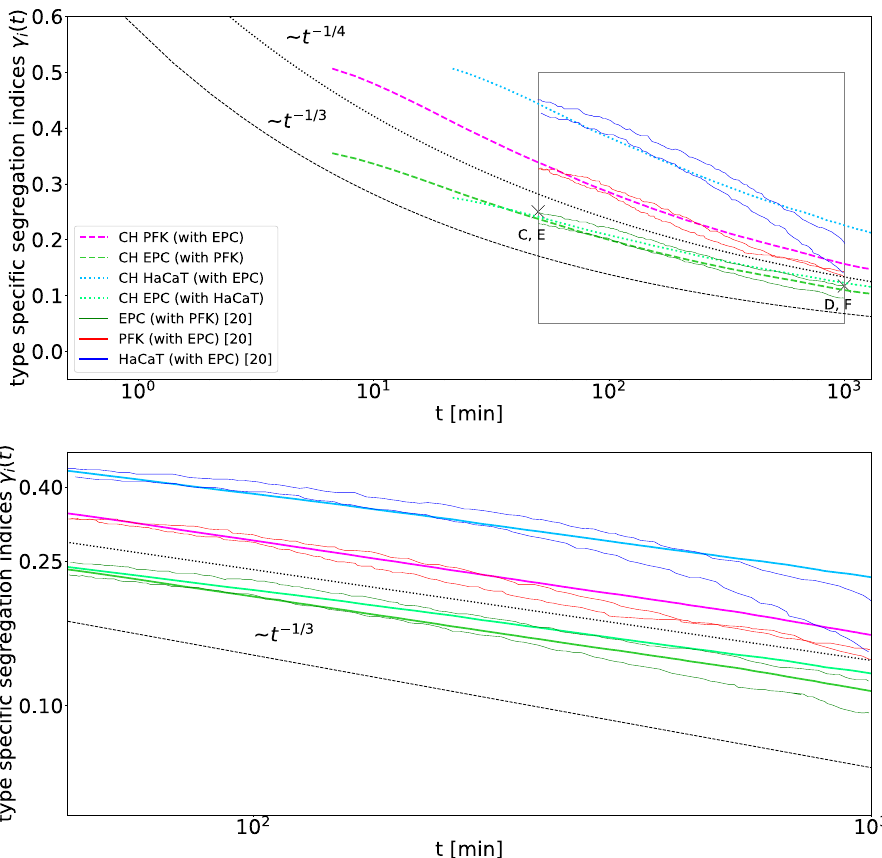
( t ) for the two experiments PFK (dark red) with EPC (dark green) and HaCaT (dark blue) i with EPC within the observed time interval 50–1000 min match the segregation indices predicted by the Cahn-Hilliard simulation (lines with corresponding brighter colors, dashed lines for PFK with EPC and dotted lines for HaCaT with EPC). Within the given time interval (grey box in top panel displayed again in bottom panel), the segregation indices of the Cahn-Hilliard simulation decay algebraically with exponent 1/4 (black dotted line) rather than 1/3 (black dashed line), which implies that the segregation process is in an intermittent regime of fluid segregation, see text for details. By using a mapping from the cellular automaton model to the Cahn-Hilliard model, see Materials and methods, parameters are set analogous to the parameters used in Fig 1 except for the mobility constant D , which is fitted to D ¼ 36 m m 2 = min for the mixture of PFK with EPC and D ¼ 18 m m 2 = min for the mixture of HaCaT with EPC. Snapshots of the cell mixtures at the points marked with crosses labeled C, E and D, F are displayed in Fig 3. Note, that the Cahn- Hilliard model is shown after the settling process took place, see Fig E in S1